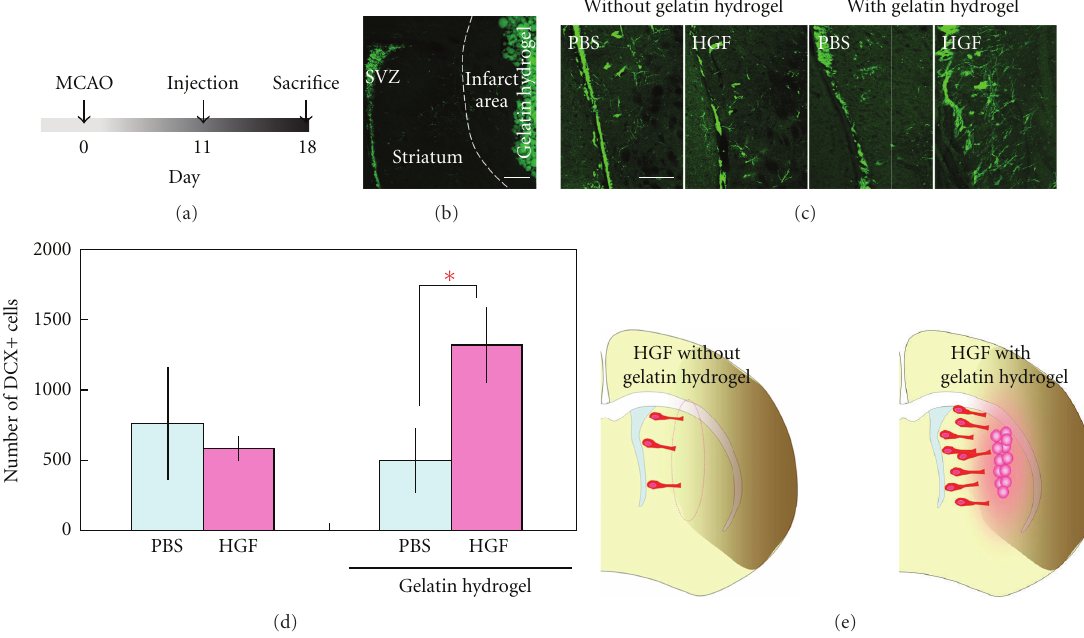
Figure 3: E ff ects of HGF-containing gelatin hydrogel on the number of new neurons migrating in the ischemic striatum after middle cerebral artery occlusion. (a) Experimental design. (b) A coronal brain section showing DCX+ new neurons in the SVZ (green) and gelatin hydrogel that was injected into the striatum. (c) Coronal sections stained for DCX (green) from brains that received a PBS or HGF injection with ( n = 6 animals for each group) or without ( n = 4 animals for each group) gelatin hydrogel. (d) Quantification of the number of DCX+ cells separated by at least 50 µ m from the SVZ in the ipsilateral striatum. (e) Summary of the results. HGF administered as HGF-containing gelatin hydrogel microspheres significantly increased the number of new neurons. Scale bars: 200 µ m (b and c). ∗ P < 0 .